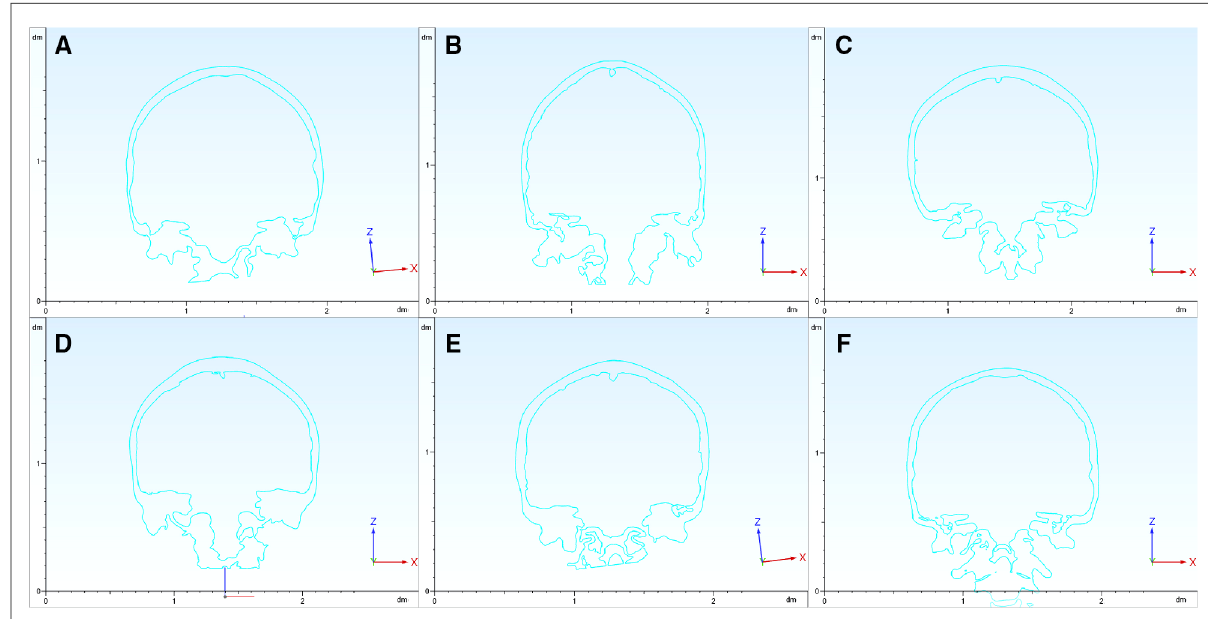
FIGURE 3 Coronal section of the skull. The coronal sections across the bilateral IAO show varied shapes among the six cases (panels A – F signify cases 1 – 6, respectively). PIA and MFBA are measured based on these coronal sections. IAO, inner acoustic ori fi ce; PIA, petrous inner angle; MFBA, middle fossa bottom